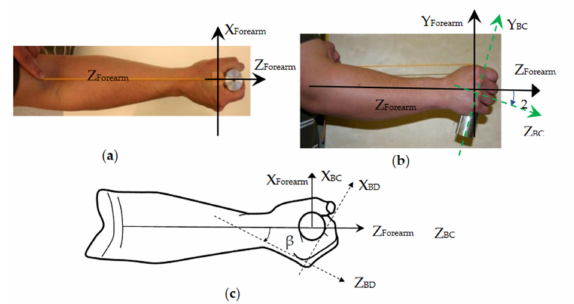
Figure 3. Comparisons of the proposed coordinate system (Forearm) with the standard hand co- ordinate systems (BC and BD) [39]: ( a ) The definition of the forearm-based coordinate system; ( b ) The comparison of the coordinate systems in the Y-Z plan; and ( c ) the comparison of the coordi- nate systems in the X-Z